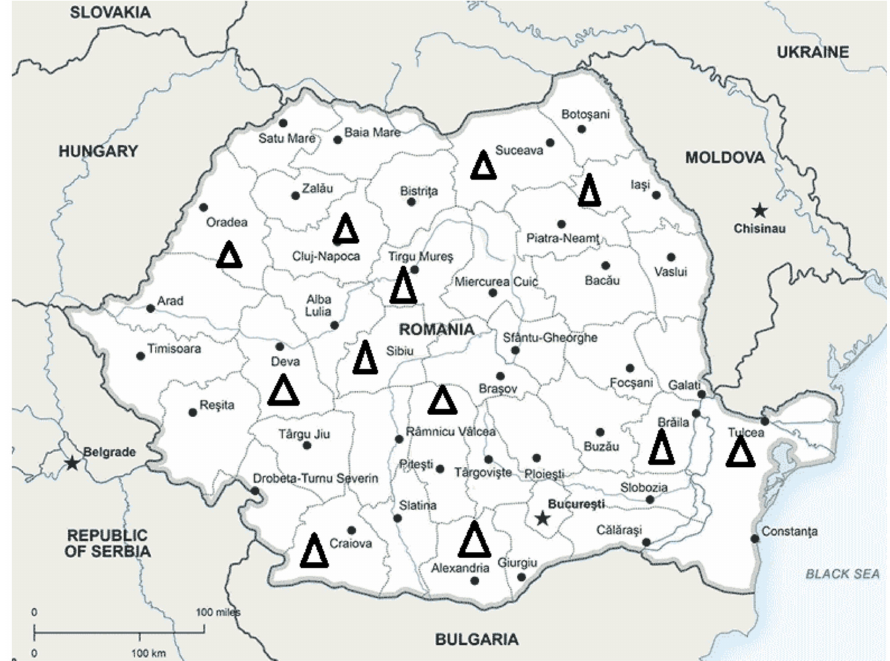
Figure 1. Study area and location of interviewed landowners on the Romania map (black triangles indicate the twelve counties where the interviews were carried